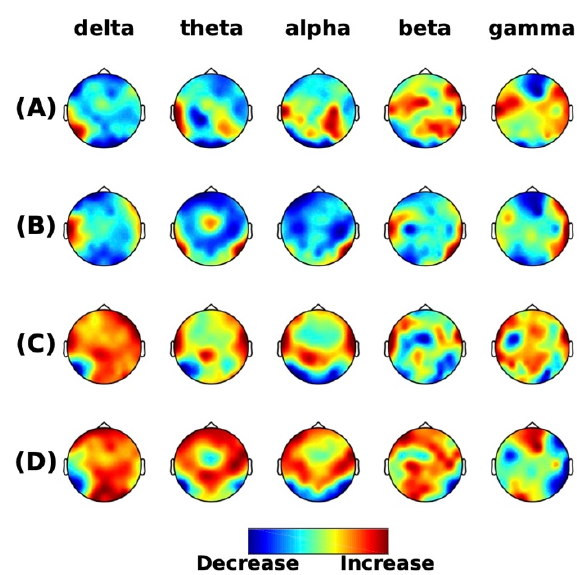
Figure 1. Resting-state frequency-domain analysis. Scalp topographies of the difference of grand averaged power from ( A ) the pre-intervention sessions (chiropractic - control), ( B ) post- and pre- control sessions, ( C ) post- and pre-chiropractic sessions, and ( D ) between interventions (( C ) minus ( B )). The cluster-based permutation tests showed non-significant differences in comparisons in ( A ), ( B ) and ( C ), however, the absolute power in all frequency bands across the scalp was higher after the chiropractic intervention.